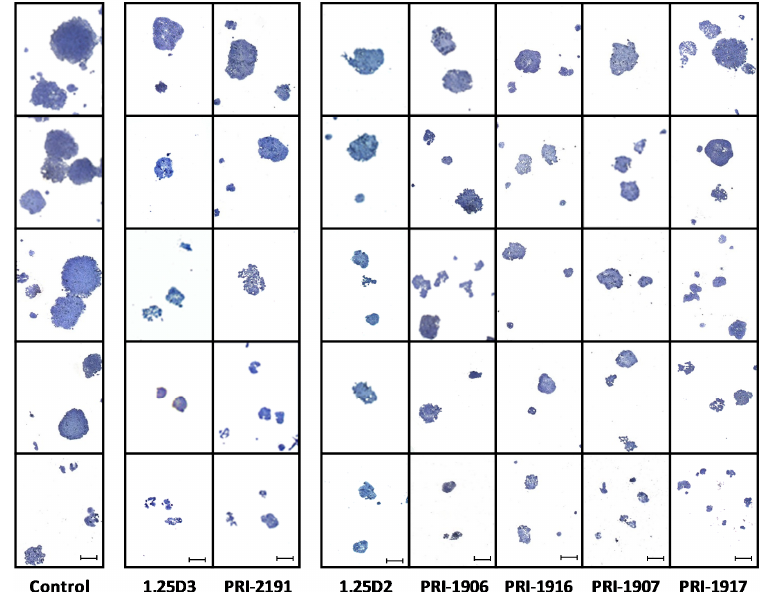
Figure 3. The size and appearance of colonies formed by HT-29/5-FU cells in the absence of the vitamin D (control), or in the presence of 1,25D3, PRI-2191, 1,25D2, PRI-1906, PRI-1916, PRI-1907 or PRI-1917. Photographs of the representative fixed colonies were taken on the 10th day of culture under the microscope at a 40-fold magnification. Five representative photographs shown for each culture type are placed in columns according to the decreasing size of colonies, starting from the top of each column. Scale bars representing 200 μ m, shown only in the bottom row, apply to every photograph.